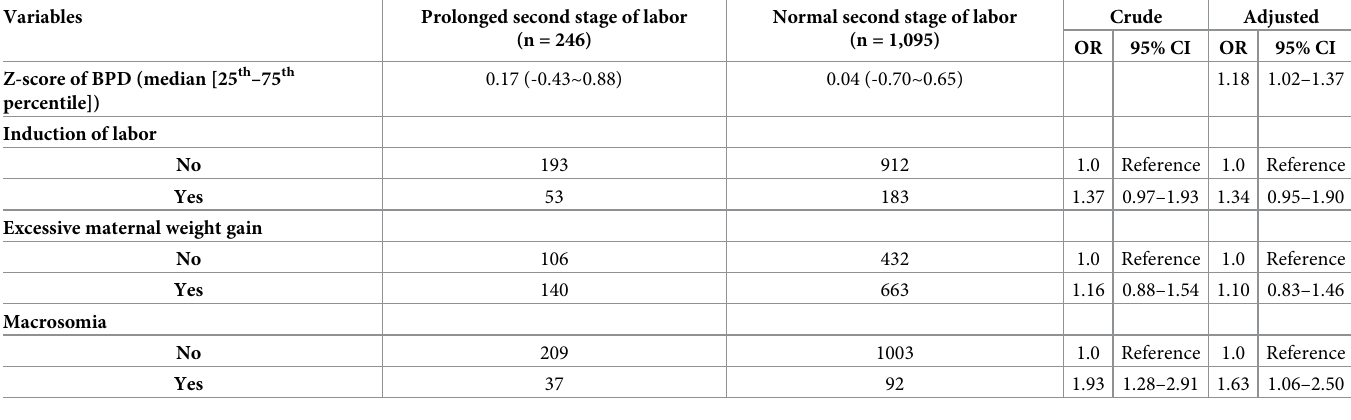
Table 5. Factors associated with prolonged second stage of labor in nulliparous women.